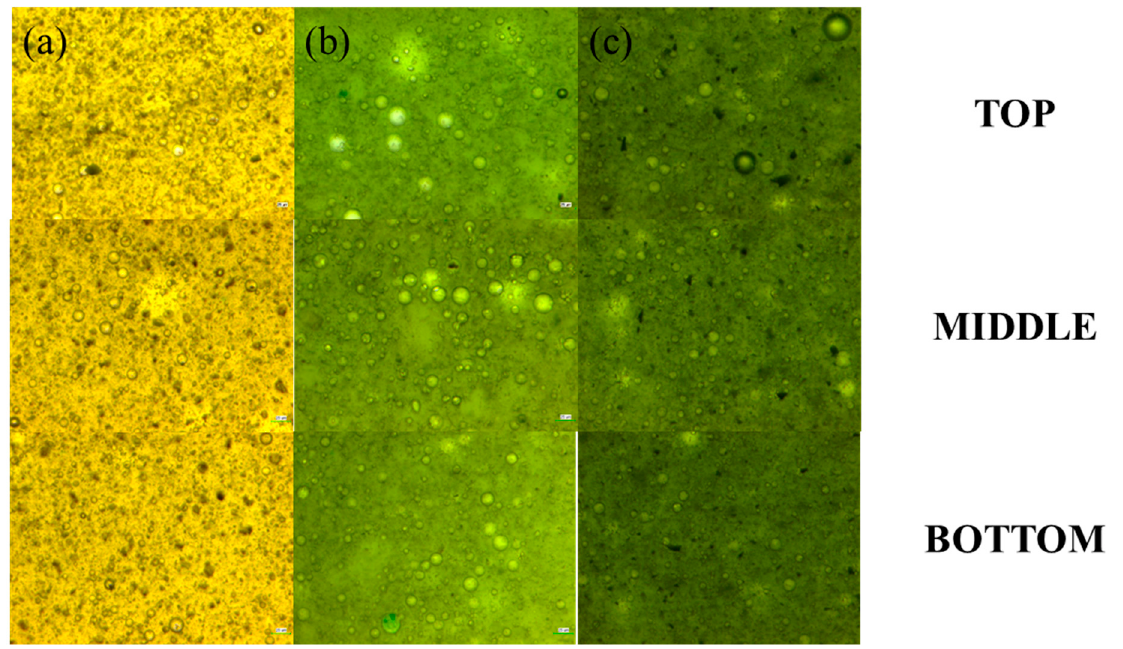
Figure 4. Photos of Pickering emulsion stabilized by three kinds of solid particles from each of the top, middle, and bottom layers under 400 × optical microscope. ( a ) CTAB-GO, ( b ) SiO 2 , ( c ) coconut shell coke.